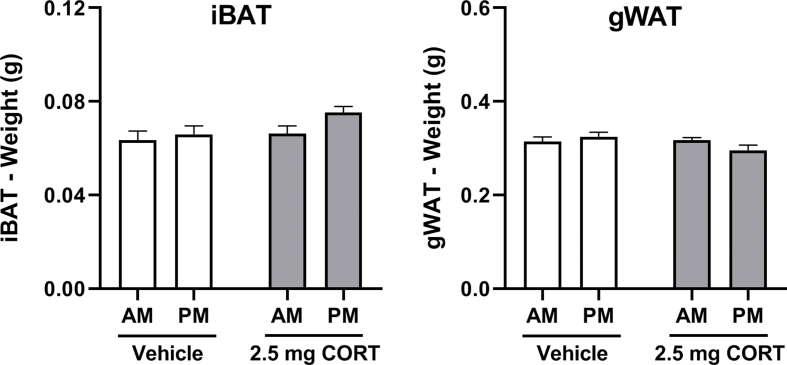
Flattening of corticosterone rhythm does not influence iBAT and gWAT tissue weight in wild-type (WT) mice. Interscapular brown adipose tissue (iBAT) and subscapular brown adipose tissue (sBAT) tissue weight in male WT mice implanted with vehicle- or 2.5-mg corticosterone (CORT) pellets for 7 days.